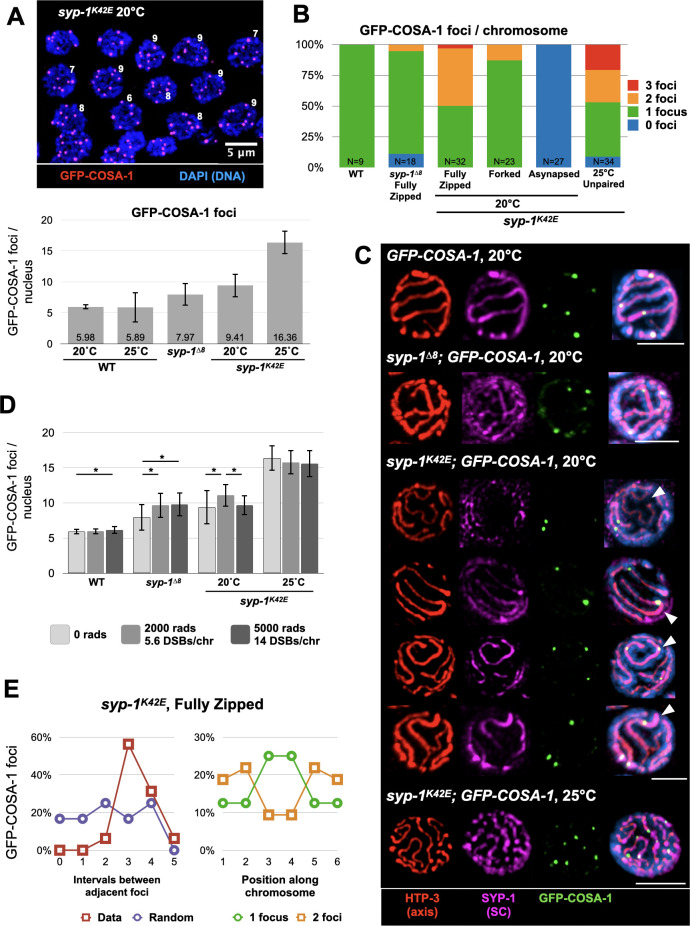
The N-terminus of SYP-1 regulates the number and distribution of crossover markers.A) GFP-COSA-1 foci are more numerous in syp-1 mutants. Top, immunofluorescence images of late pachytene syp-1K42E nuclei showing the number of GFP-COSA-1 foci per nucleus (red). Scale bar = 5μm. Bottom, the average number of GFP-COSA-1 foci per nucleus in the indicated genotypes. Error bars indicate standard deviation. N>30 nuclei from at least three gonads for each condition. All pairwise comparisons to wild type are significant (Student’s t-test, p<0.005). B) The number of GFP-COSA-1 foci per chromosome traced in 3D in the indicated genotypes. Chromosomes in syp-1K42E animals are shown by the type of chromosome morphology (fully zipped, forked and asynapsed). N values are shown at the bottom of each bar. C) Examples of GFP-COSA-1 localization relative to the SC. Partial projections of immunofluorescence images of detergent-extracted pachytene nuclei form animals of the indicated genotypes. Nuclei were stained with antibodies against HTP-3 (red), SYP-1 (magenta) and GFP (green; GFP-COSA-1), and with DAPI (DNA; blue). Scale bars = 3μm. Notably, GFP-COSA-1 foci are associated with the SC in all scenarios. syp-1K42E; GFP-COSA-1 (20°C): Top row, unpaired chromosome that is not associated with the SC (arrowhead) also does not recruit GFP-COSA-1. 2nd row, fully zipped chromosome with a single GFP-COSA-1 focus (arrowhead). 3rd row, a fully zipped chromosome with two foci (arrowhead). Bottom row, a forked chromosome (arrowhead) with a single GFP-COSA-1 focus in the zipped region. Throughout our images we found that GFP-COSA-1 foci were not enriched near forking junctions (only 1/25 junctions was associated with a focus, and only 4 of 25 foci (16%) were <1μm from a junction), arguing against the idea that crossovers locally stabilize the SC. syp-1K42E; GFP-COSA-1 (25°C): Note multiple GFP-COSA-1 foci along single chromosomes. D) The number of GFP-COSA-1 foci is not limited by the number of double-strand breaks. GFP-COSA-1 foci in animals of the indicated genotypes after being exposed to varying amounts of X-ray irradiation (2000 and 5000 Rads), creating 5.6 and 14 extra breaks per chromosome, respectively. See S4 Fig for analysis of X-ray induced breaks. Error bars indicate standard deviation. N>20 nuclei from at least three gonads for all conditions. Significant intra-genotype comparisons are shown (Student’s t-test, p<0.05). E) Intact but reduced interference between crossover precursors. GFP-COSA-1 foci were identified along completely zipped chromosomes in syp-1K42E (20°C) animals, and their positions were placed into six equal bins. Left, in chromosomes that harbor two foci, the foci are more distant from each other (maroon) than would be expected by chance (‘Random’, purple). Right, histograms of the position along the chromosome, normalized around the center of the chromosome. When 2 foci are present (orange), they tend to be at the opposite ends of the chromosomes. N = 15 chromosomes from at least three gonads.